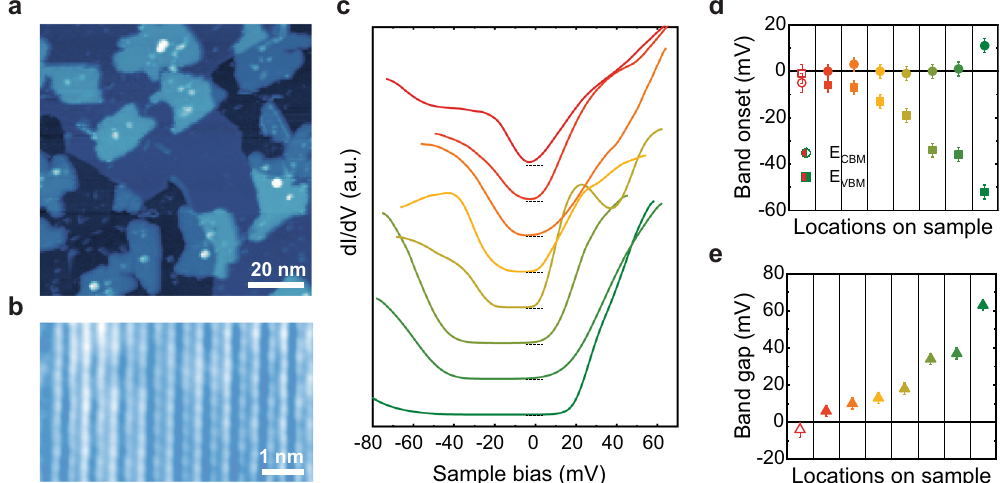
Fig. 3 Band gap variations in ML-WTe 2 fi lm grown on graphene on SiC. a Typical large scale STM topography of ML-WTe 2 fi lms. b Atomically resolved image of one of the monolayer islands. c d I/ d V spectra taken on the same sample arranged in the order of decreasing band gap. The spectra shown were taken from monolayer islands without any visible defects from different, randomly chosen 1 µ-size locations on the 4 × 5 mm sample (see Supplementary Fig. 4). d , e Conduction band minimum (CBM), valence band maximum (VBM) ( d ), and band gap ( e ) plotted for the spectra shown in ( c ).